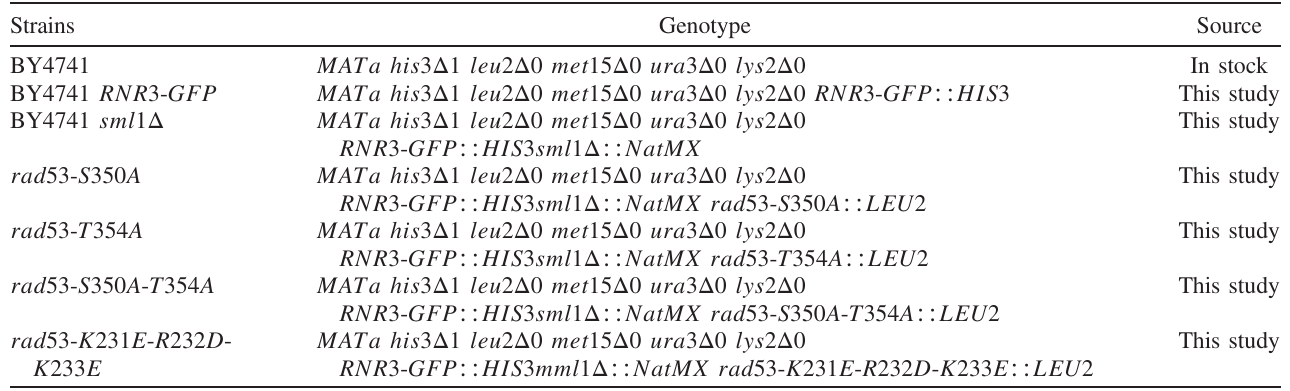
TABLE III. Yeast strains used in this